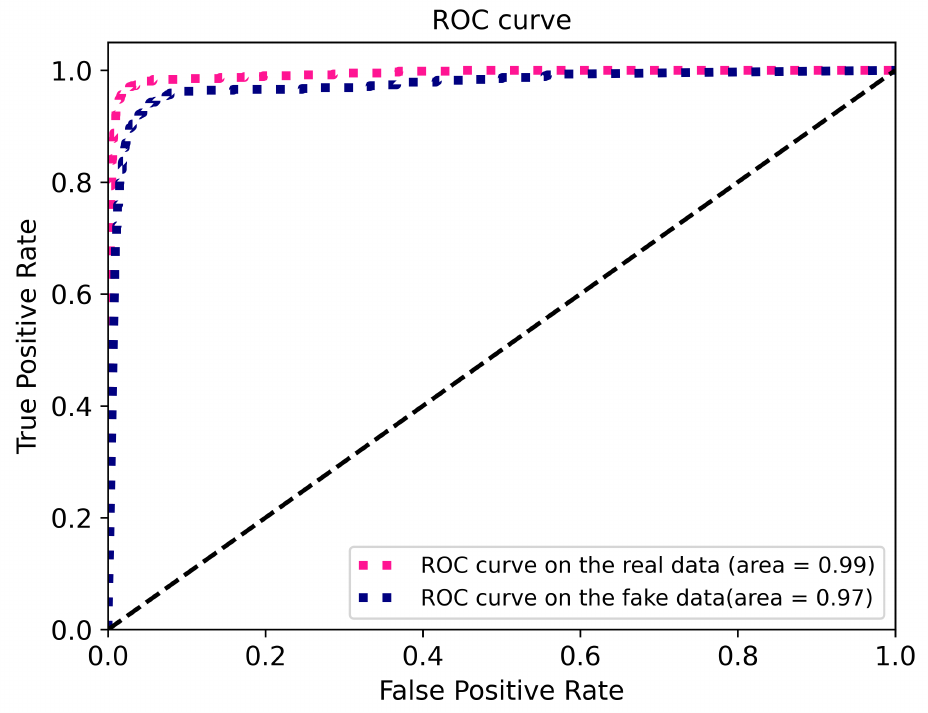
Figure 11. ROC curve by the level